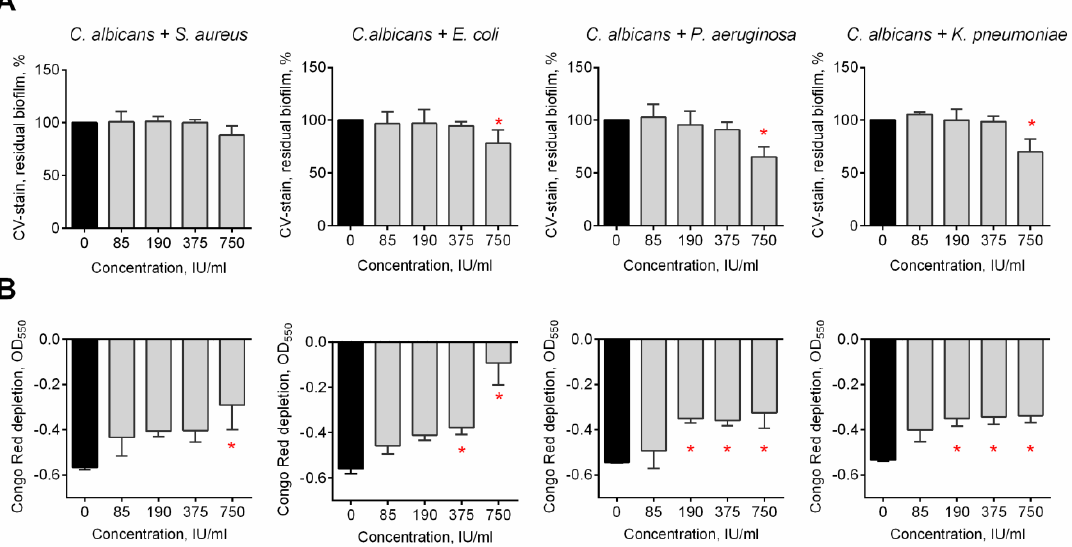
Figure 3. The effect of Longidaza ® on fungal–bacterial biofilms. forty-eight-h-old fungal–bacterial biofilms were washed and incubated 24 h in fresh BM broth supplemented with 85 − 750 IU of Longidaza ® as indicated. Biofilms were quantified with either ( A ) crystal violet staining or ( B ) Congo Red depletion assay. Asterisks denote significant difference with untreated samples (* p <